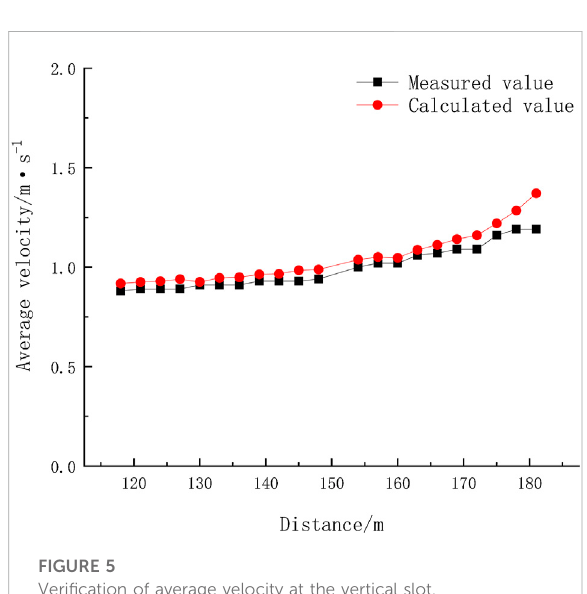
FIGURE 5 Veri fi cation of average velocity at the vertical